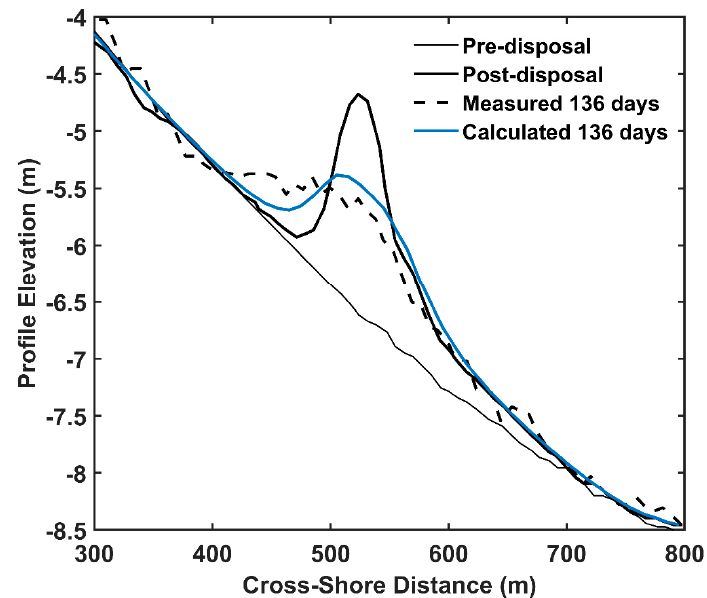
Figure 2. Comparisons between measured and calculated profiles 136 days after the mound placement, Cocoa Beach.